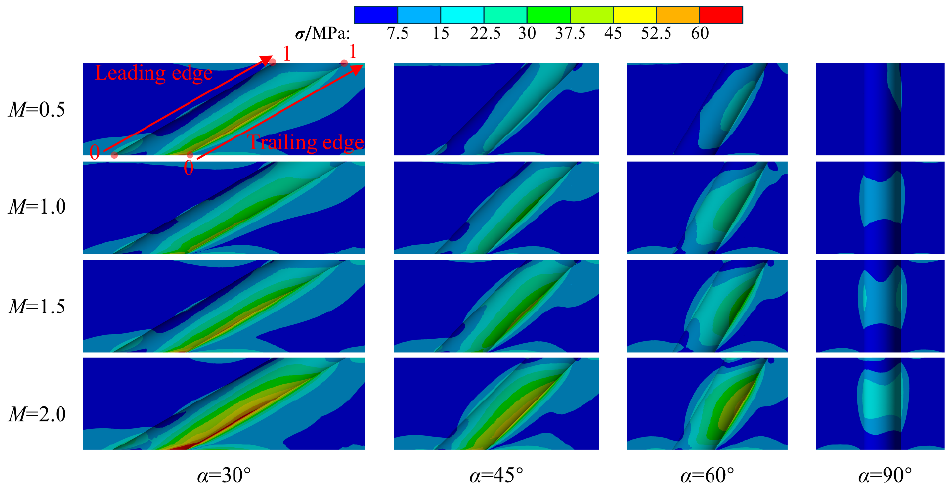
Figure 18. Contours of thermal stress at Y = 0 plane near the research film hole.